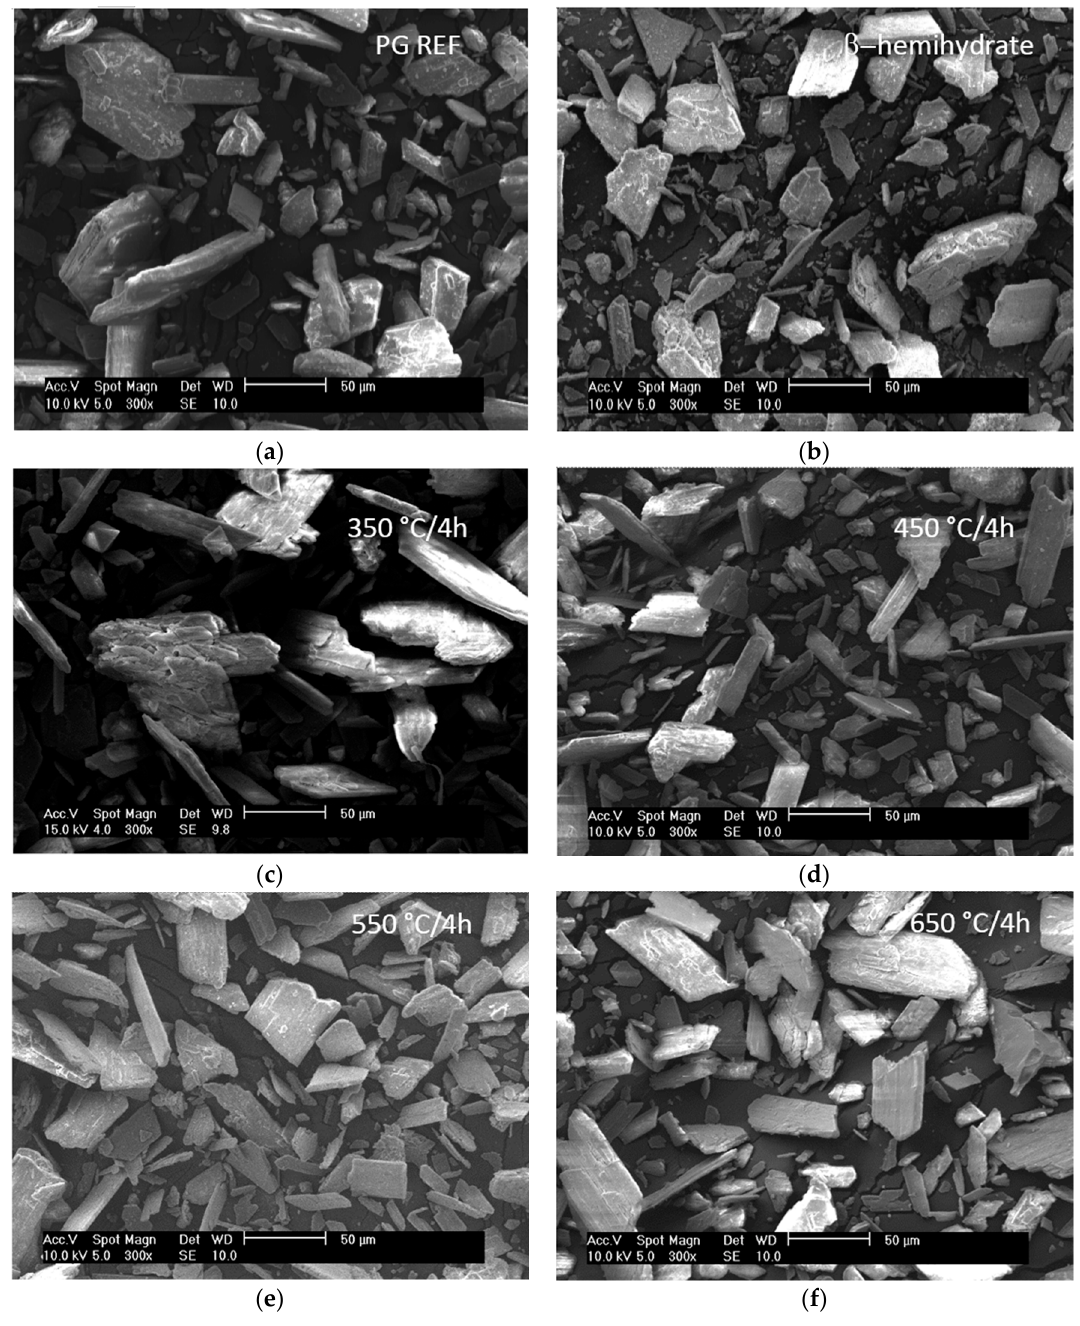
Figure 4. Morphology of calcium sulfate samples: phosphogypsum (PG REF) ( a ); β -hemihydrate ( b ); and PAs obtained at temperatures of 350 °C ( c ); 450 °C ( d ); 550 °C ( e ); and 650 °C ( f ).